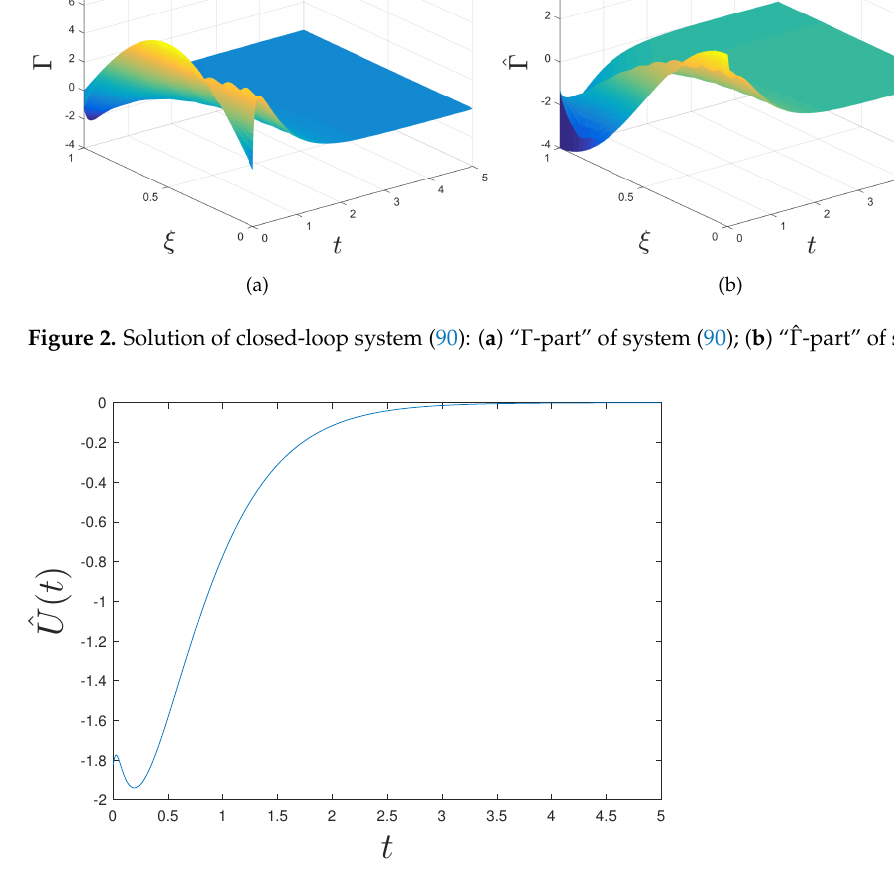
Figure 3. Trajectory of the controller